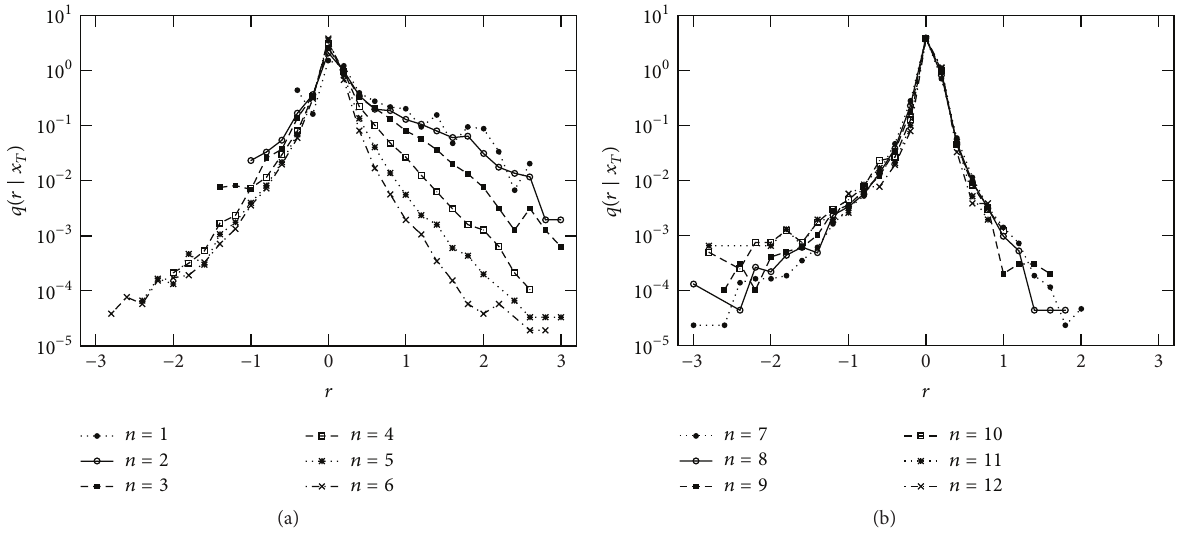
𝑥 𝑇 and 𝑇+1 are sales in consecutive